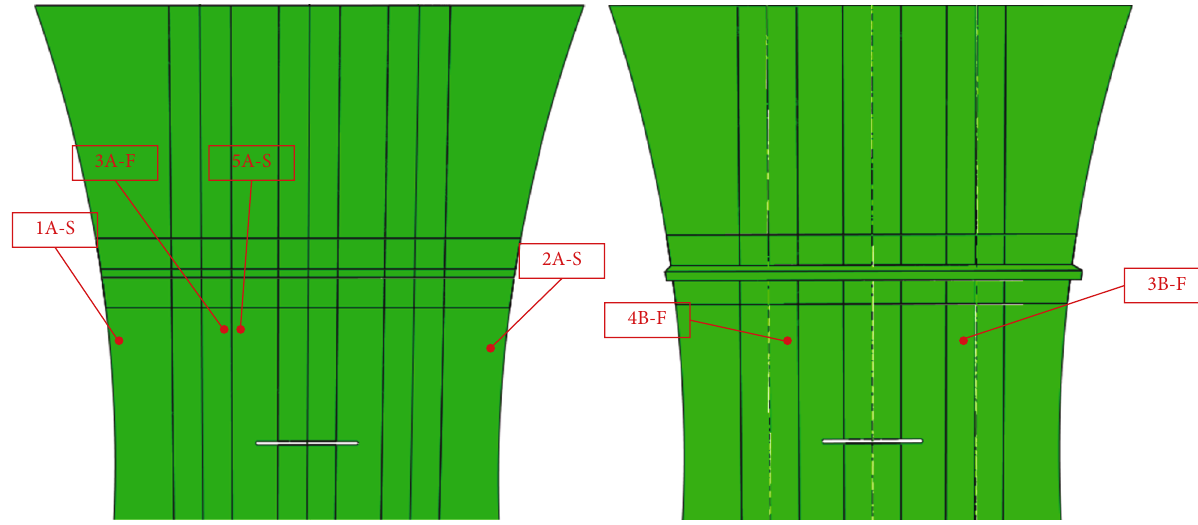
Figure 8: Locations of the simulated strain gages.